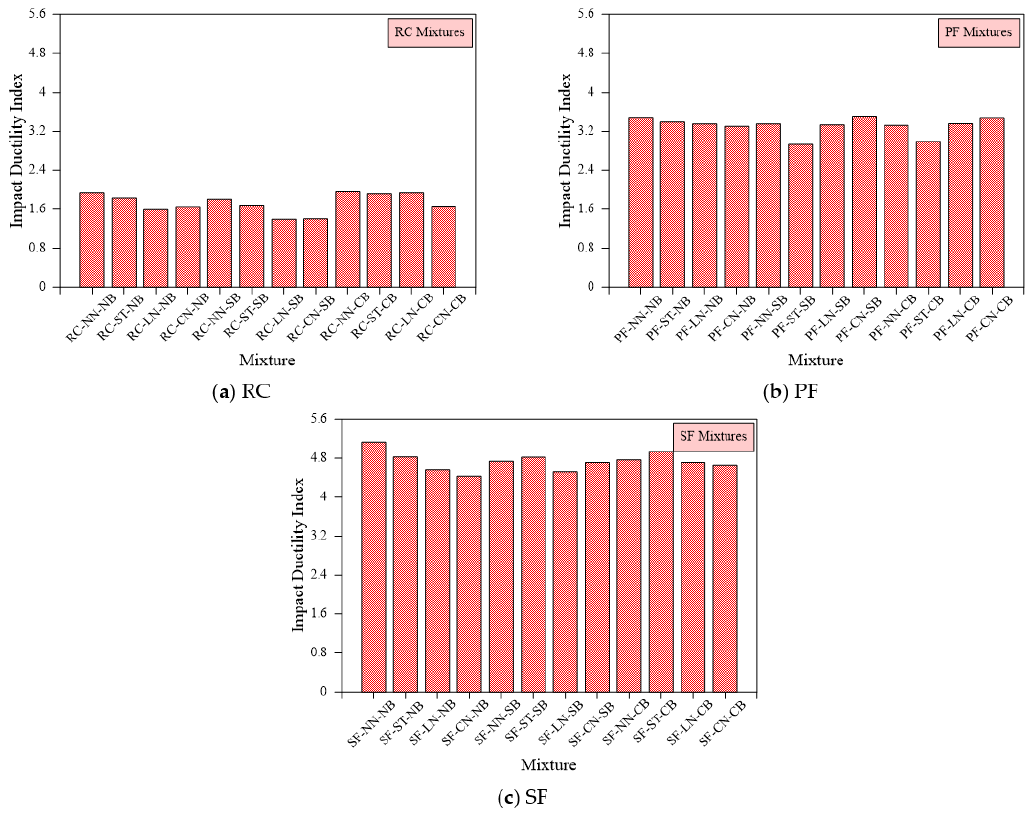
Figure 12. Impact ductility index of all mixtures ( a ) RC, ( b ) PF ( c )